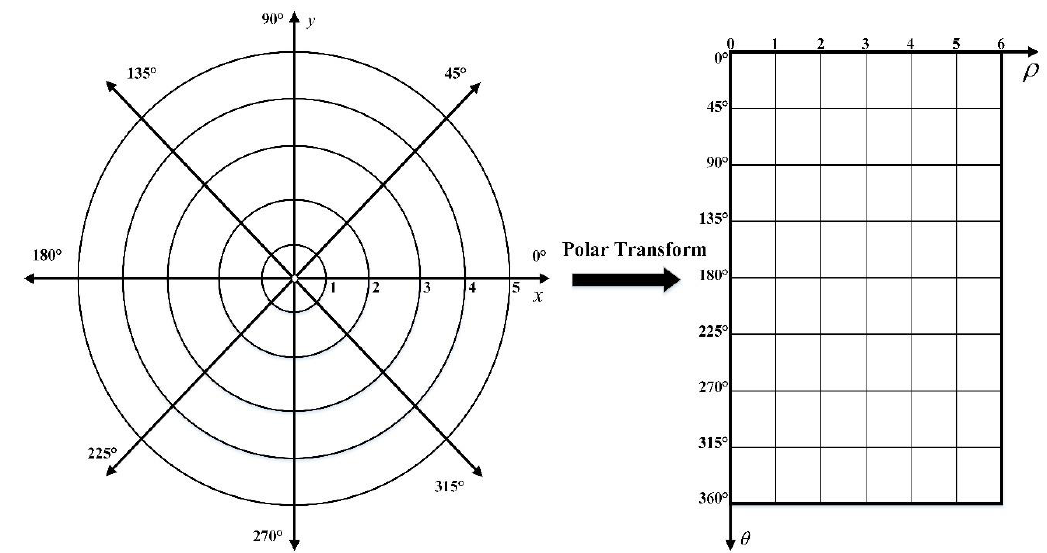
Figure 4. Correspondence of ( left ) Cartesian coordinates and ( right ) polar coordinates.